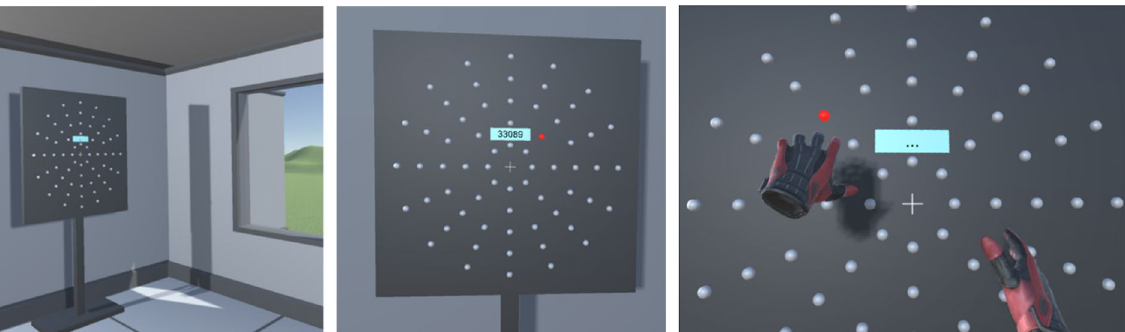
Figure 1. Left panel: large view of the designed virtual environment. Middle panel: cognitive condition of the VMVR task, with numbers appearing on the LCD screen. Right panel: finer view of the display illustrating the virtual buttons arranged in concentric circles with on illuminated target. Gloves represents the controllers the user holds in his